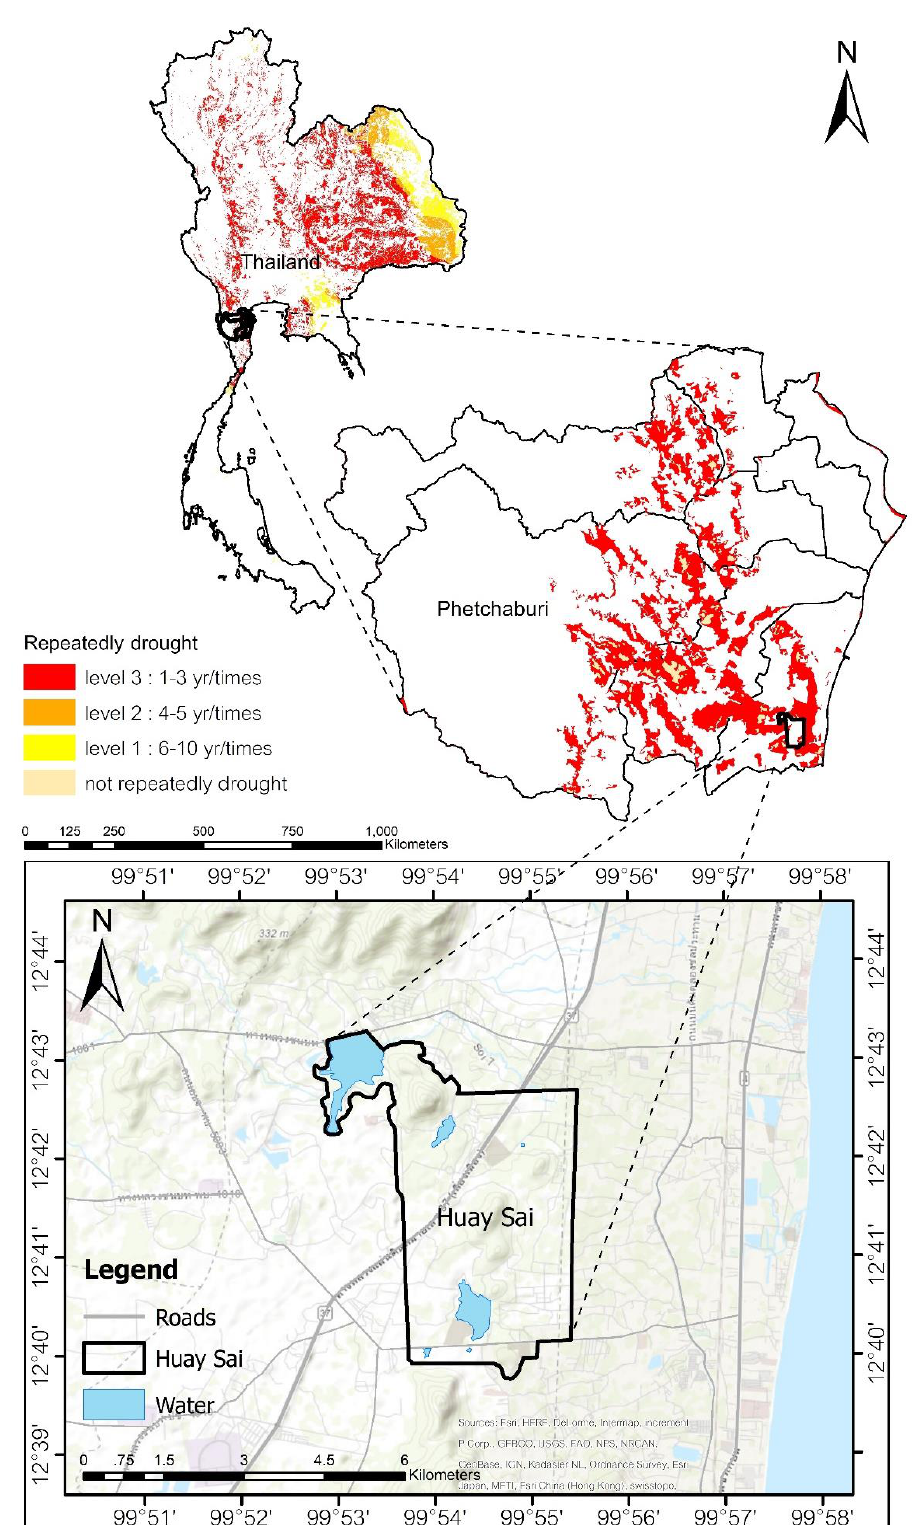
Figure 1. Huay Sai Area and the situation of drought in Thailand. Huay Sai is located in Cha-am district, Phetchaburi province, Thailand (Figure 1). The study area, Huay sai, covers an area of approximately 18,414,600 m 2 (1,841 ha). The area is mostly piedmont plateaus with a 2%–5% slope, an average rainfall of 954.8 mm / y and an evaporation rate of 1711 mm /